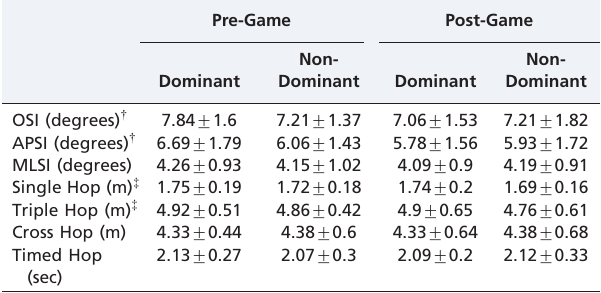
Table 1 - Means and standard deviations of the stability indices and function tests in the pre- and post-game